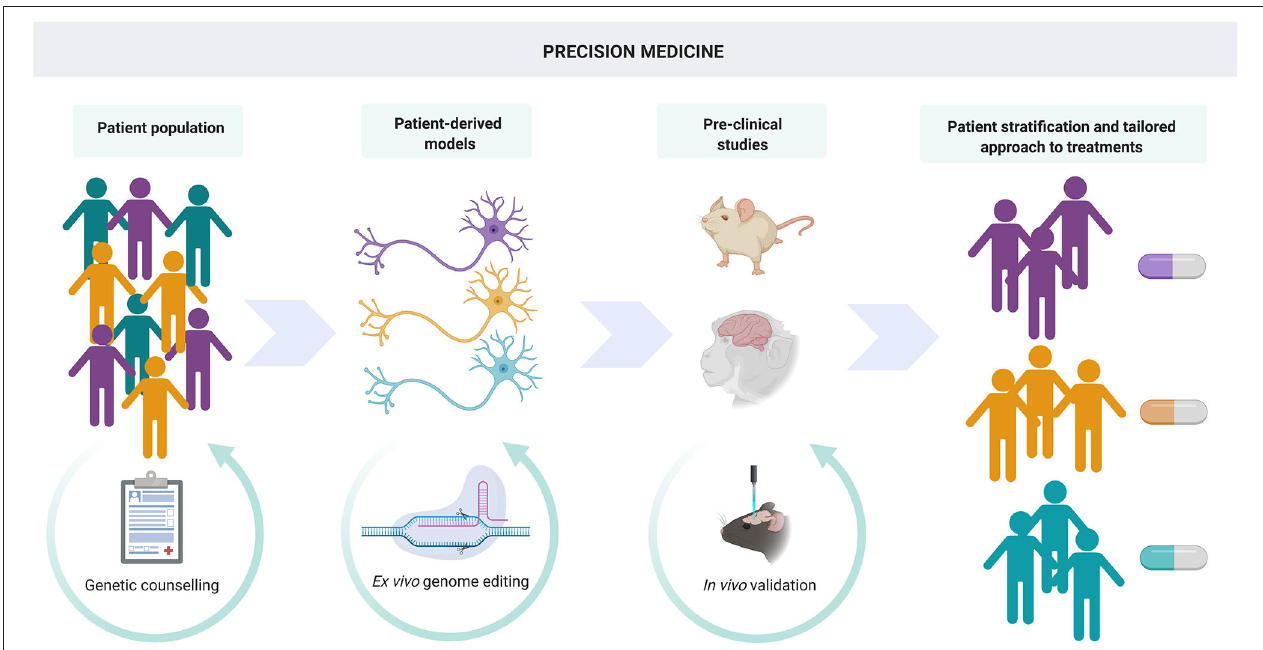
FIGURE 4 | Precision medicine. iPSC and gene editing techniques can lead to advances not only in understanding disease mechanisms through in vitro modeling but also in the development of novel, personalized therapies. Genome editing of patient-derived cells in conjunction with assessment of efficacy and toxicity in in vivo models allows patient stratification and a tailored approach to